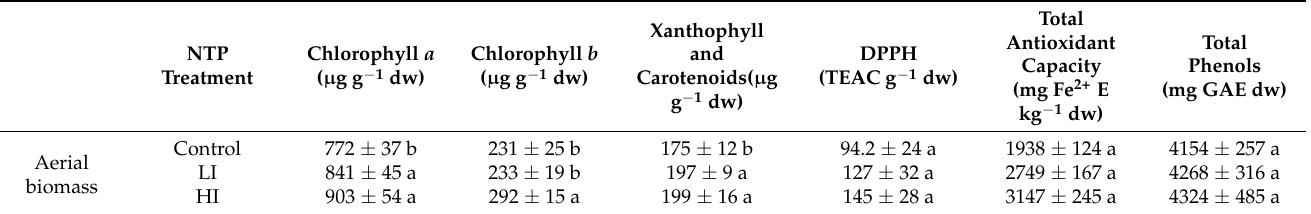
Table 6. Effect of non-thermal-plasma-activated nutrient solution on the content of leaf pigments in